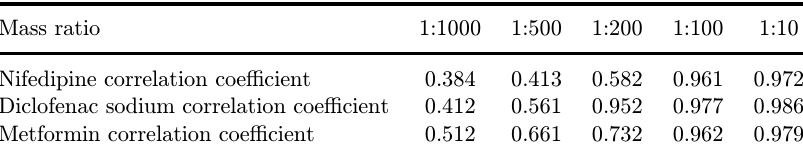
Table 1. Detection limits of the method used in nifedipine, diclofenac sodium and metformin mixed with betacyclodextrin.